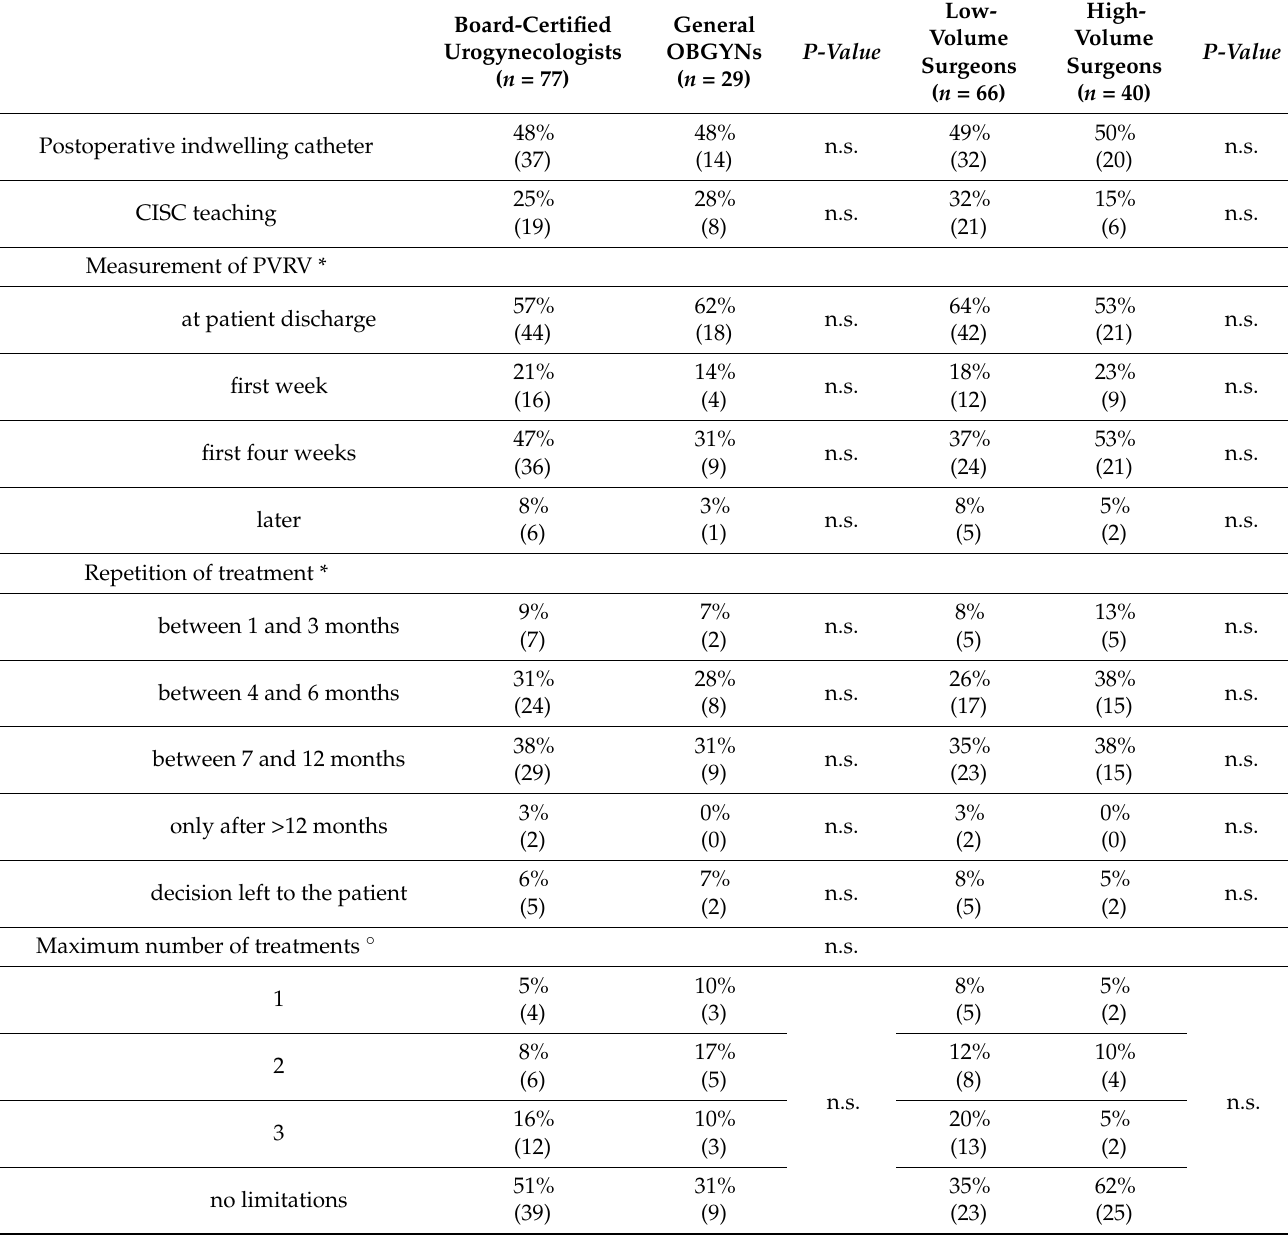
Table 3. Postoperative care, with comparisons between board-certified urogynecologists and general OBGYNs and between low-volume and high-volume surgeons. CISC = clean intermittent self- catheterization, n.s. = not statistically significant, PVRV = postvoid residual volume. * Cumulative percentages can be more than 100% because participants were allowed to give more than one answer. ◦ Cumulative percentage can be more than 100% because of